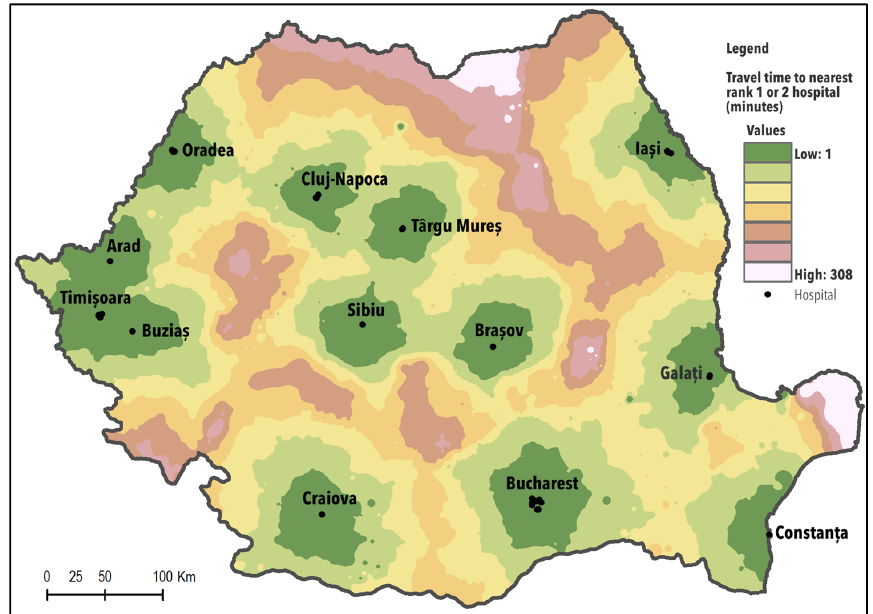
Figure 3. Potential geographical access to high-level competency hospitals (category I and II).